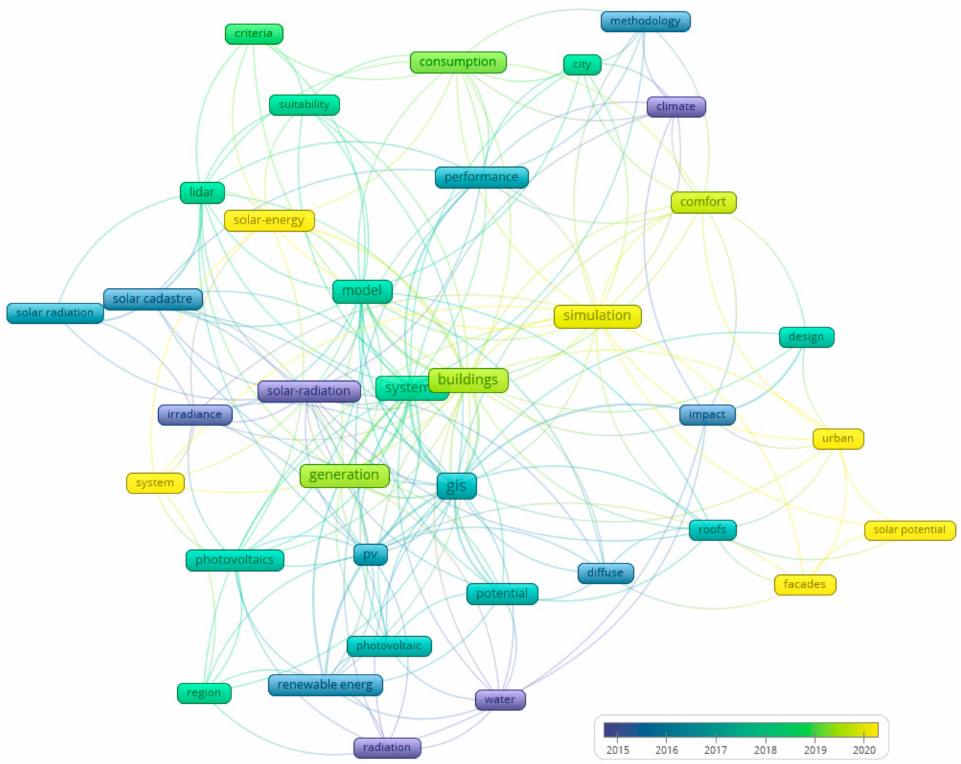
Figure 4. The average publication year of the documents from Web of Science in which a keyword occurs. Source: own study.